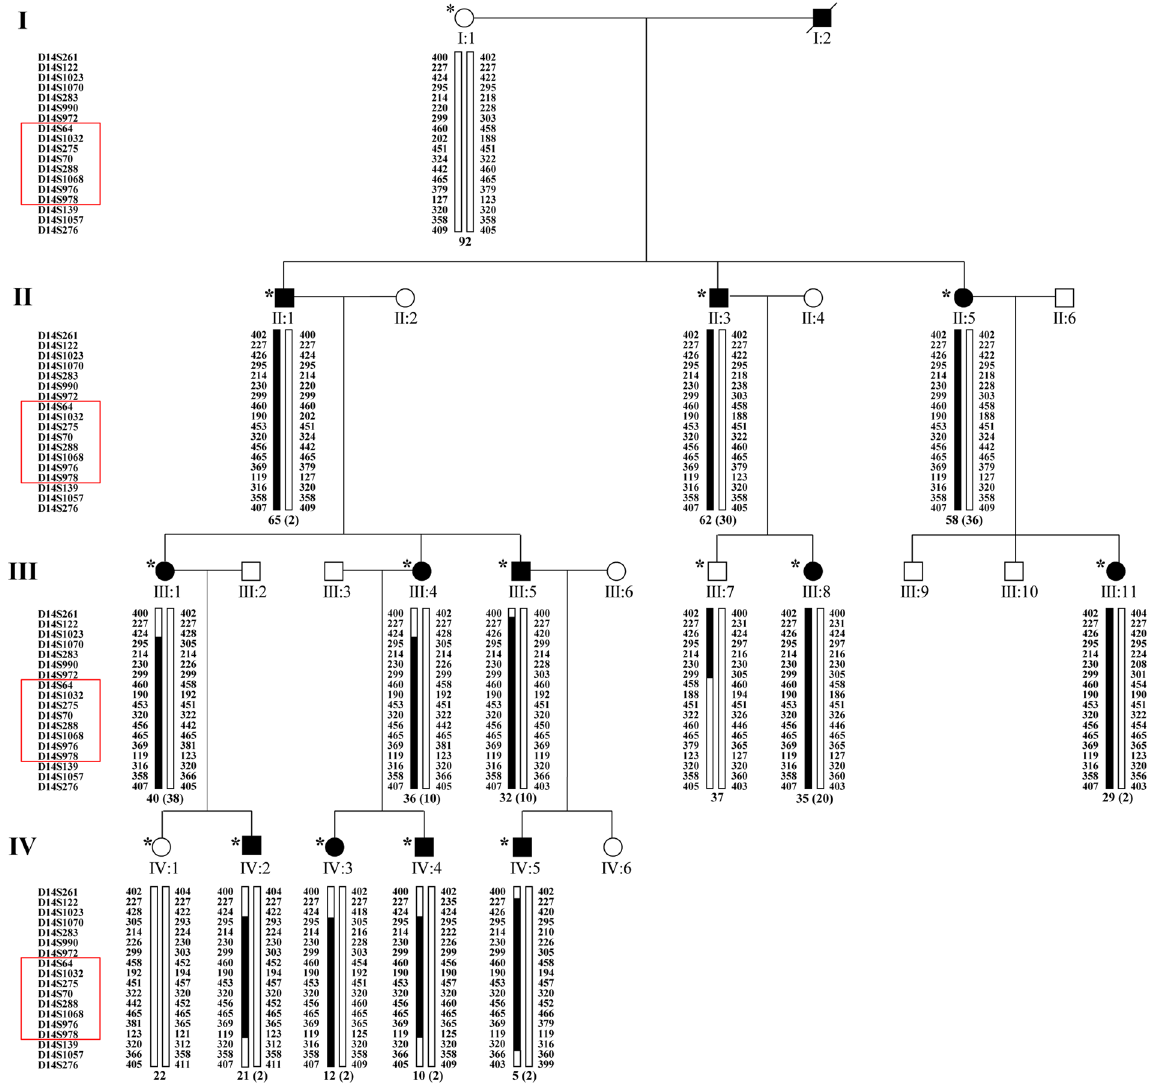
black arrow. Haplotypes for tested microsatellite markers in the mapped region and those flanking it are given for all participants. Black bars represent the ancestral haplotype associated with the disease. * Individuals from whom blood samples were collected. The mapped region flanked by markers D14S972 and D14S139 was shared by all patients and was absent in all unaffected